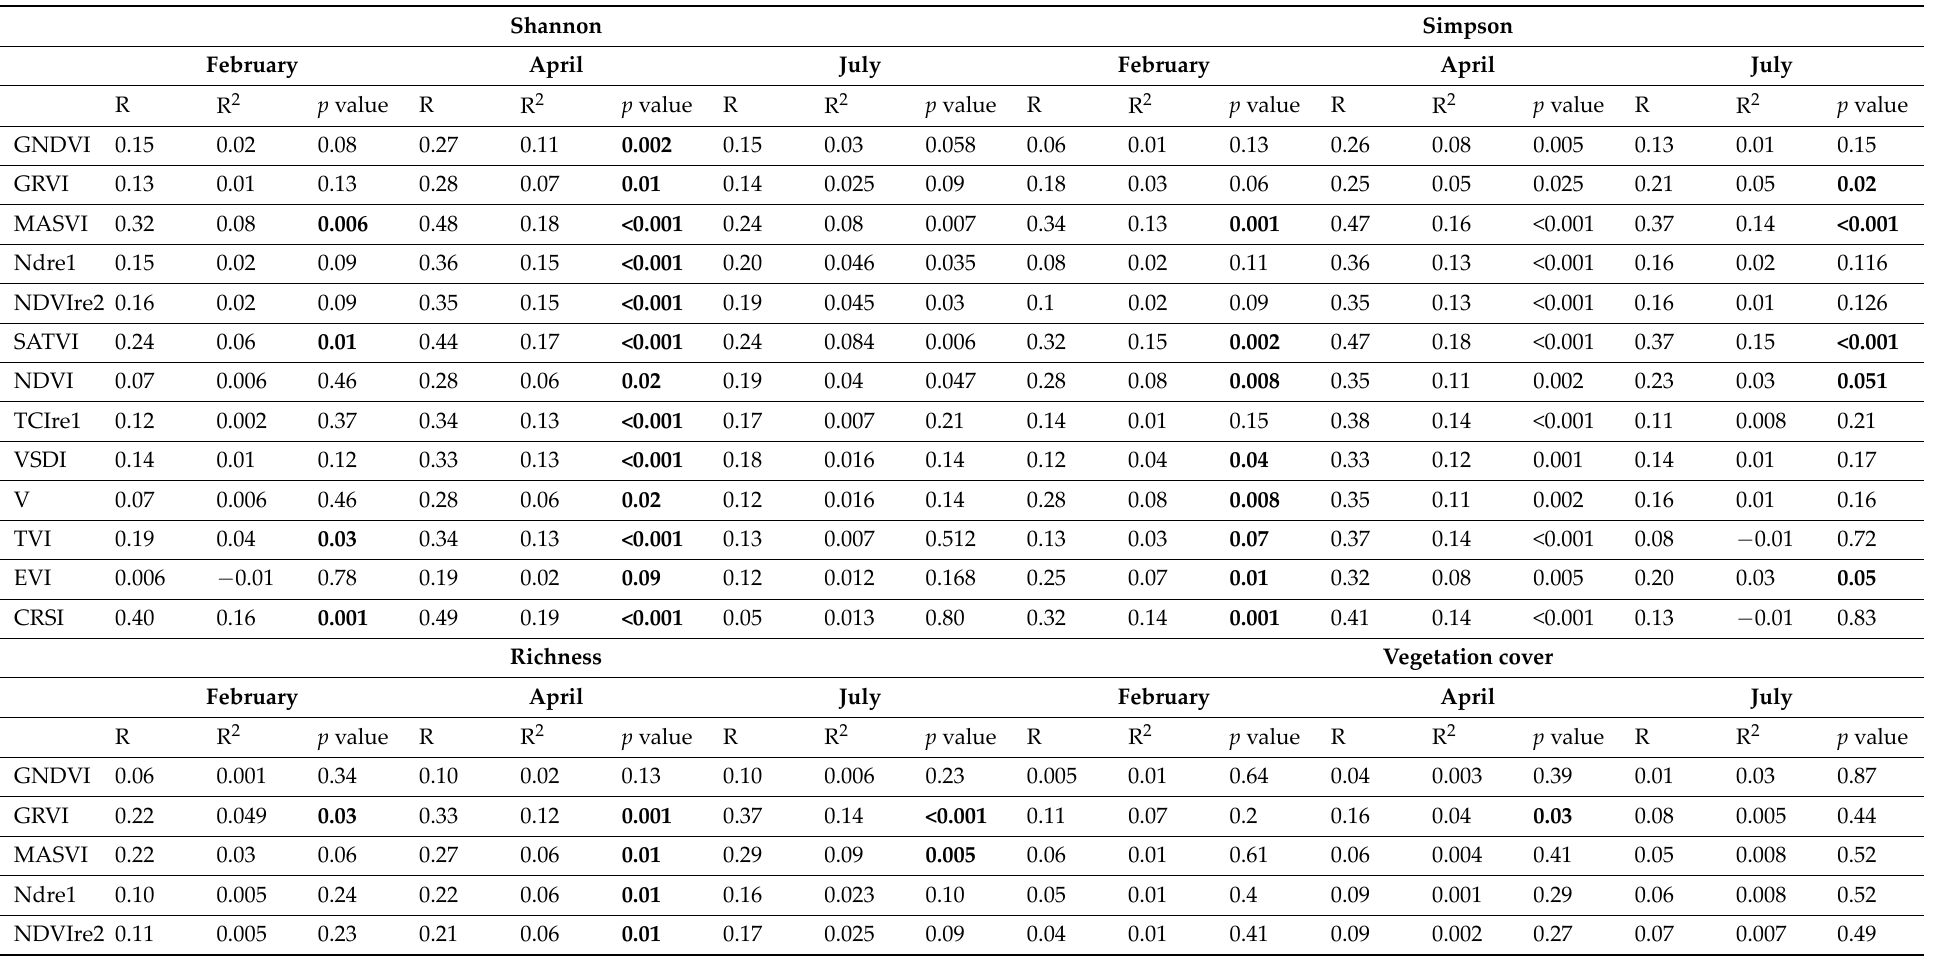
Table 2. Results of general linear models testing the effects of geodiversity and spectral variables on plant species diversity (Shannon H and Simpson), richness, and vegetation cover in the selected